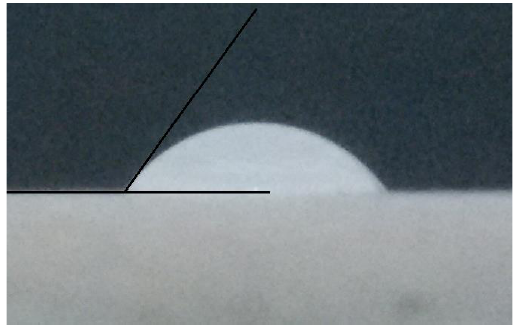
Fig. 3. Water contact angle of hybrid